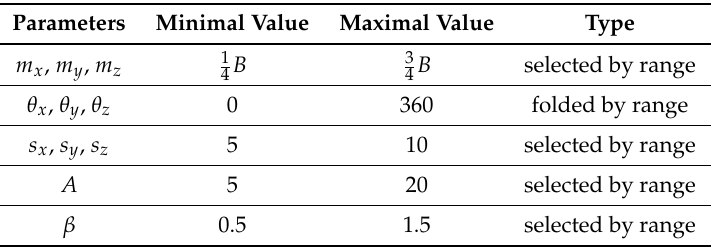
Table 2. Ranges used for